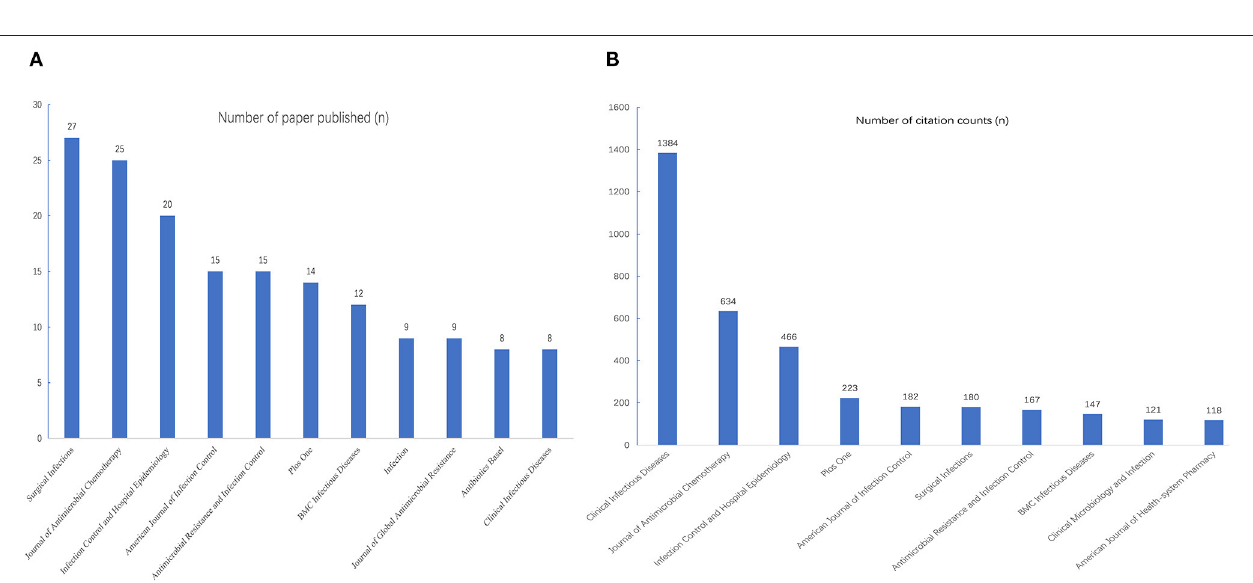
FIGURE 4 | The top ten most active journals. (A) The top ten journals with most-cited publications of AMS in surgery; (B) The top ten journals with most published papers of AMS in surgery.